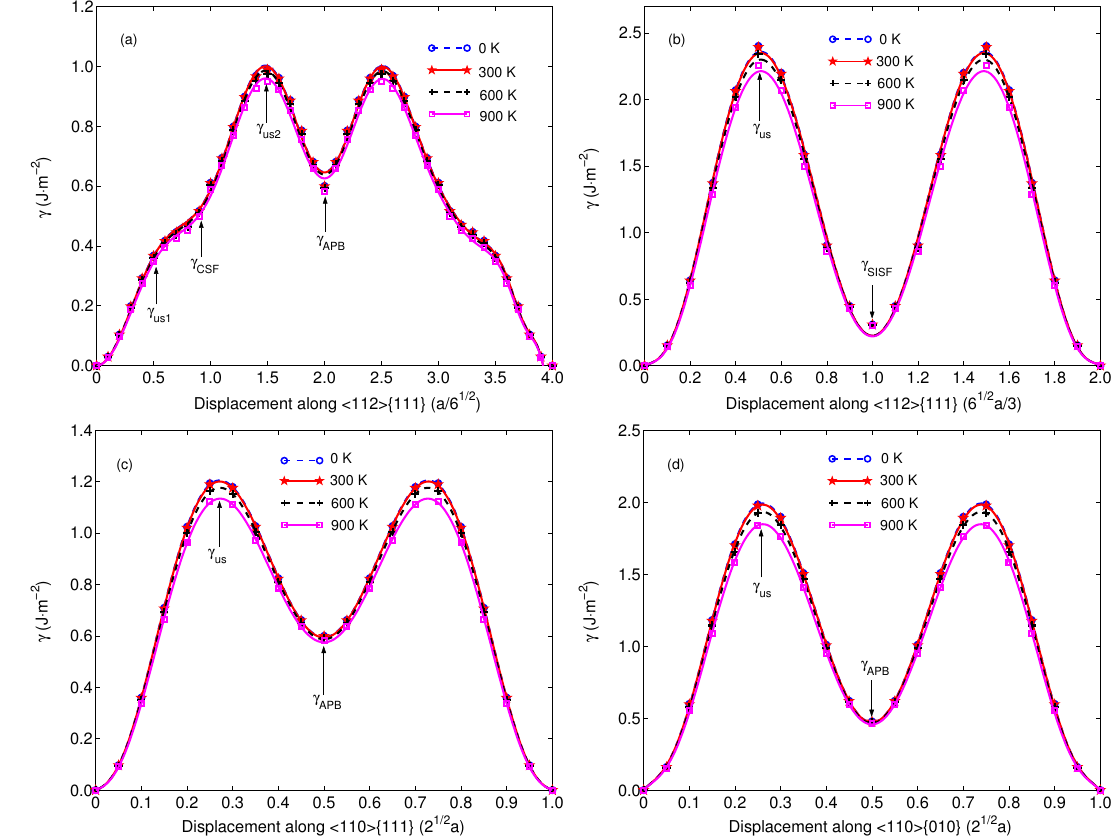
Figure 4. The calculated generalized stacking fault energy curves for Ni 3 Si ( a ) sliding along (cid:104) 112 (cid:105){ 111 } ( a /6 1/2 ), ( b ) sliding along (cid:104) 112 (cid:105){ 111 } (6 1/2 a /3), ( c ) sliding along (cid:104) 110 (cid:105){ 111 } (2 1/2 a ) and ( d ) sliding along (cid:104) 110 (cid:105){ 010 } (2 1/2 a ). The discrete points represent the results from first-principles calculations and the curves denote the results from polynomial